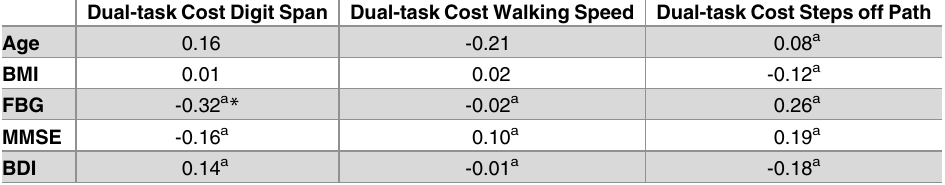
Table 3. Relationships between sample characteristics and WART task performancein subjects with